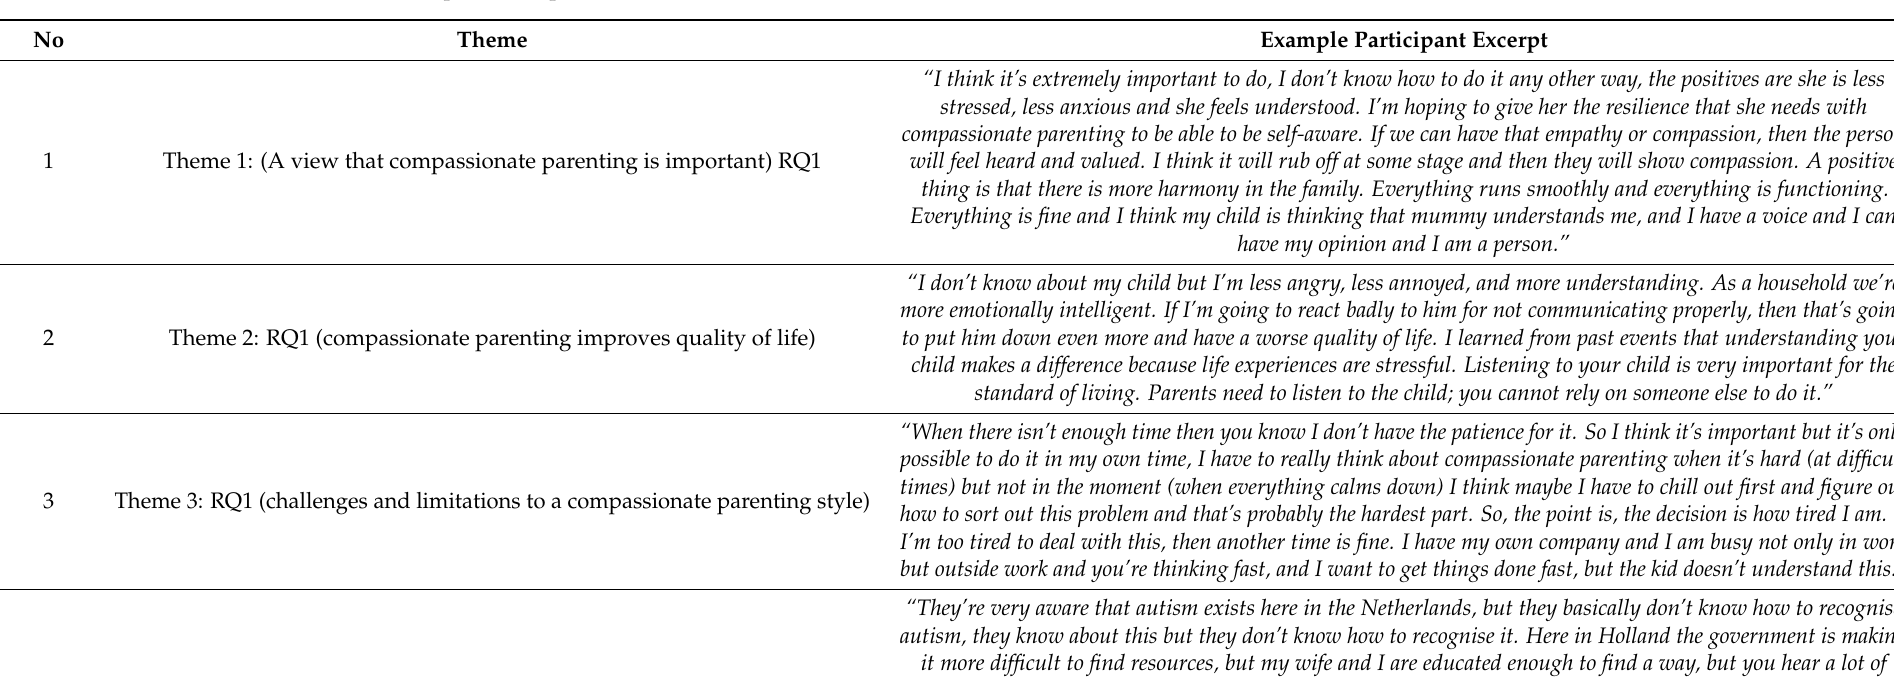
Table 2. Responses to